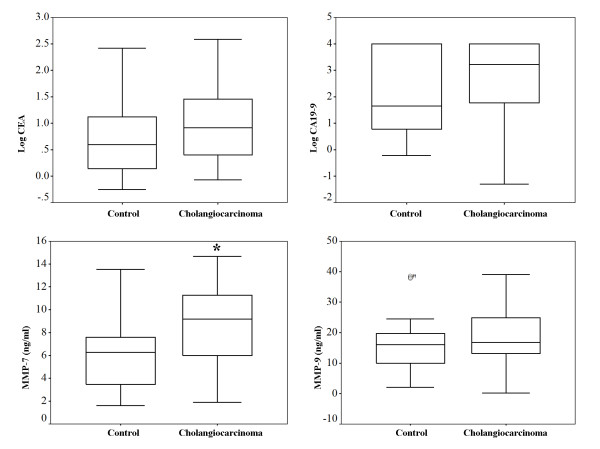
Serum levels of CEA, CA19-9, MMP-7 and MMP-9 in cholangiocarcinoma and control (benign biliary tract disease) patients. Box plots comparing levels of CEA, CA19-9, MMP-7 and MMP-9 are demonstrated. Levels of MMP-7 and MMP-9 are presented as ng/ml, while CEA and CA19-9 are presented with the log data to accommodate the wide range. *; Only the value for MMP-7 between the two groups is significantly different (Student's t-test; p < 0.001).